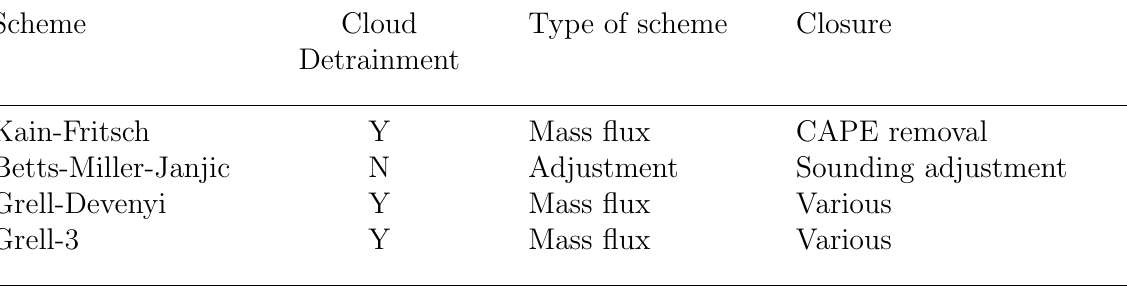
Table 8.2: Cumulus Parameterization